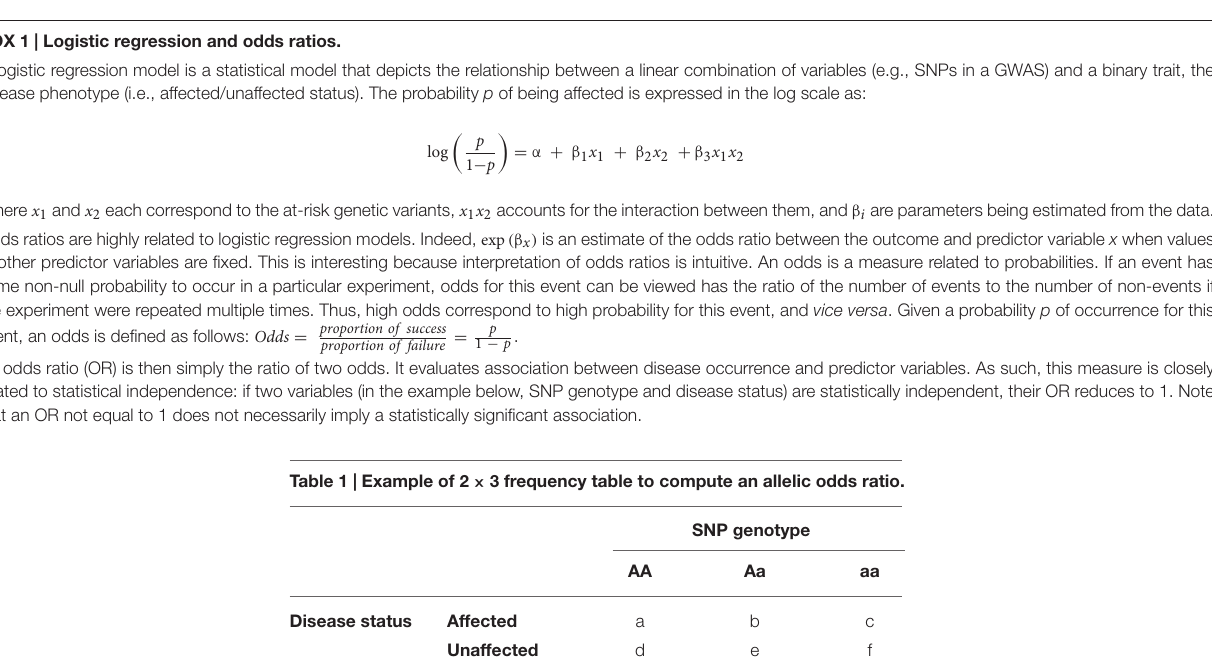
FIGURE 1 | Toy example of epistasis. (A) Neither SNP 1 nor SNP 2 presents a marginal effect. (B) In gray cells, allele combinations between SNP 1 and SNP 2 induce statistically significant epistatic effect on the phenotype distribution.